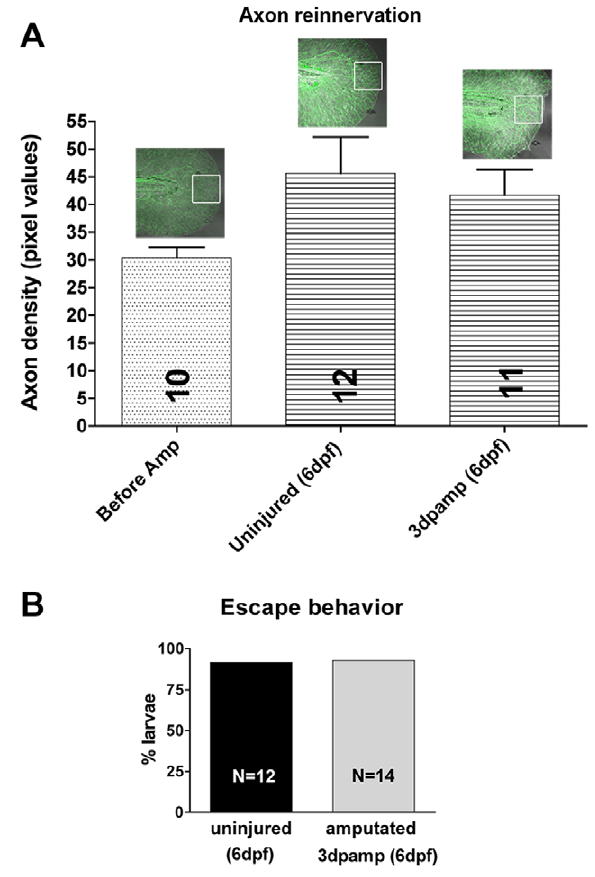
Figure 2. Sensory axons innervate regenerated fins. (A) Quantification of the density of axons within regenerated fins as measured by pixel density in a 50 m m 2 area (white box) at the distal fin tip. No significant difference was found between groups (one-way ANOVA and Bonferroni’s post-test for comparison of all groups was applied; p = ns . 0.05). (B) Reinnervating sensory axons are functional. Uninjured larvae at 6 dpf were compared to amputated larvae at 3 dpa (6 dpf) in their ability to escape in response to touch stimuli at the caudal fin tip (11/12 uninjured fish escaped, 13/14 injured/regenerated fish